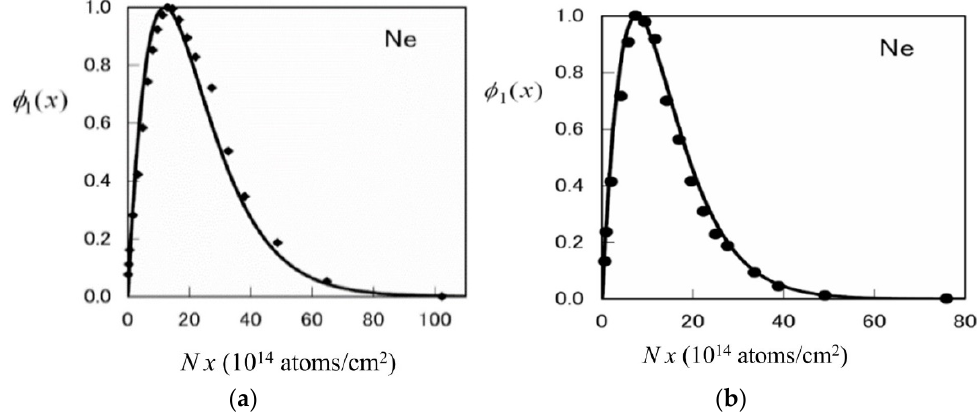
+ + and ( b ) 4 C ions as a function